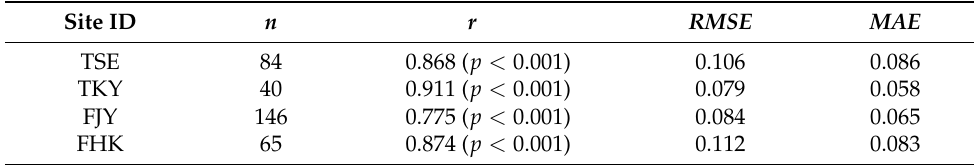
Figure 10. Scatter plots between CCI satellite and CCI simulated . CCI satellite was screened with the QA flag (QA = 2). The dotted line represents the 1 : 1 line. The black solid line is the linear regression line. The shape of each point represents the year: the circle is 2018, the triangle is 2019, and the square is 2020. The color of each point corresponds to the DOY. Table 7. The statistics of the accuracy assessment between CCI satellite and CCI simulated